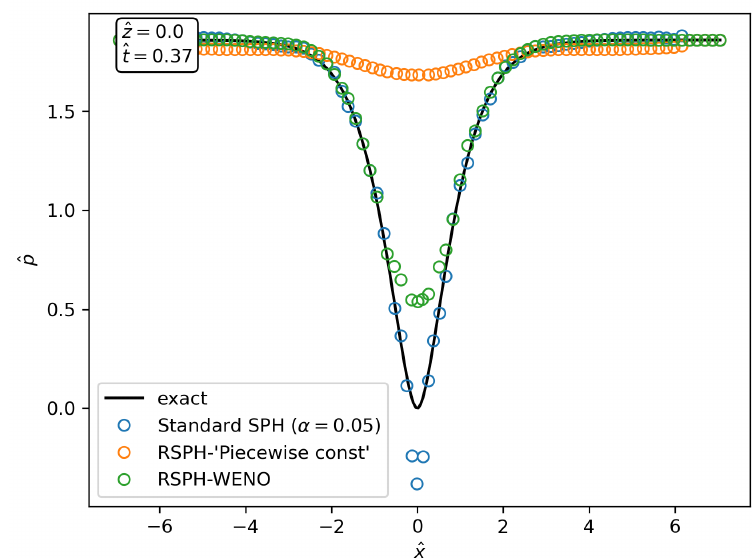
Figure 3. Pressure distribution of the 2D vortex along the line ˆ z = 0 and at time ˆ t = 0.37, computed with three different schemes: standard SPH with artificial viscosity ( α = 0.05), RSPH with a piece-wise constant reconstruction, and RSPH with a WENO reconstruction. The resolution is R / ∆ x =